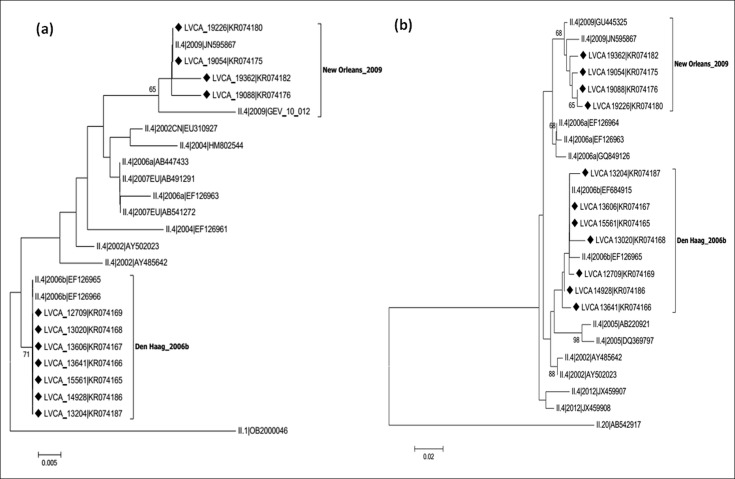
Phylogenetic analyses of NoV GII.4 sequences based on the polymerase region (ORF1) and capsid region (ORF2).(a) Phylogenetic tree of 231 bp within the polymerase region (3’ ORF1). (b) Phylogenetic tree of 277 bp within the capsid region (5’ ORF2). References strains of NoV GII.4 variants are named according to GenBank with their respectively accession numbers. Brazilian GII.4 strains are marked with a filled diamond. The scale bar at the bottom of the tree indicates distance. Bootstrap values (2,000 replicates) are shown at the branch nodes and values lower than 60% are not shown.